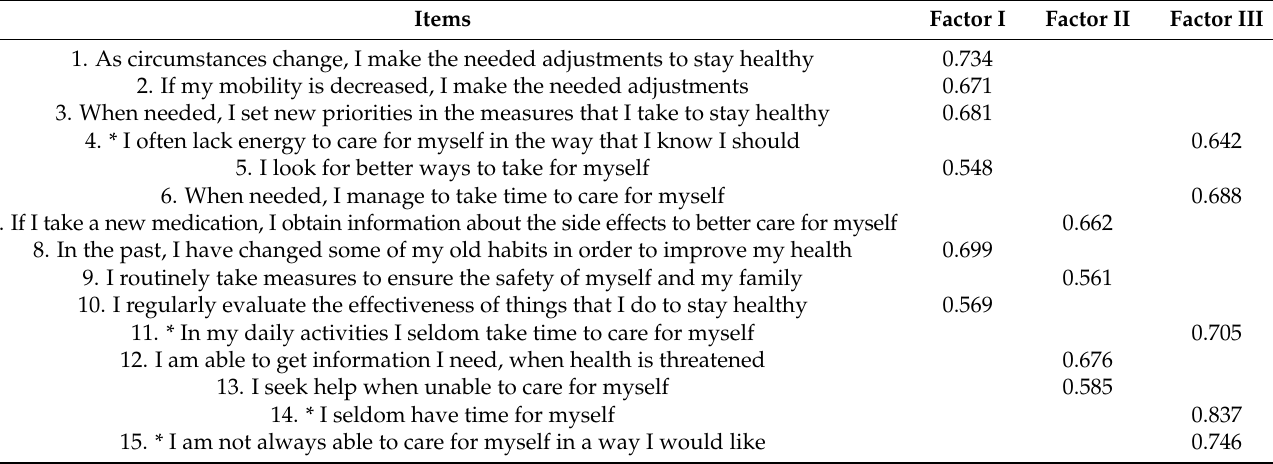
Table 3. Composition of the three factors extracted for the ASAS-R scale with factor loadings (>0.4) of the items, obtained by main component analysis ( n = 781).